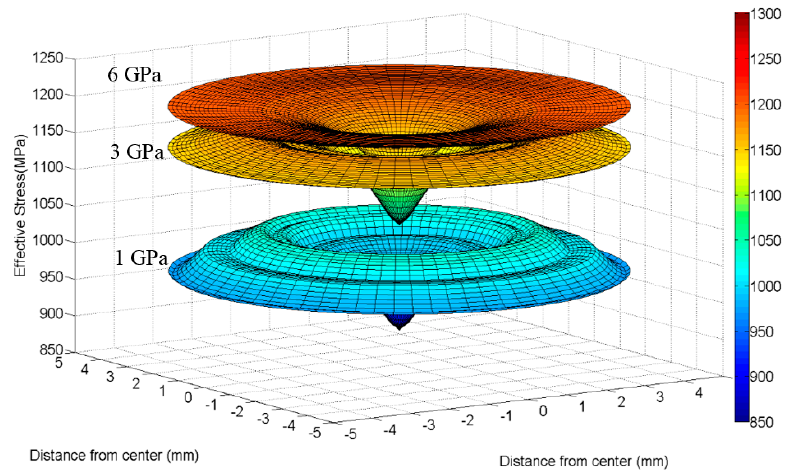
Figure 6. Distribution of effective stress across the disc surface after processing by HPT for a 1/2 turn under pressures of 1 GPa, 3 GPa and 6 GPa.